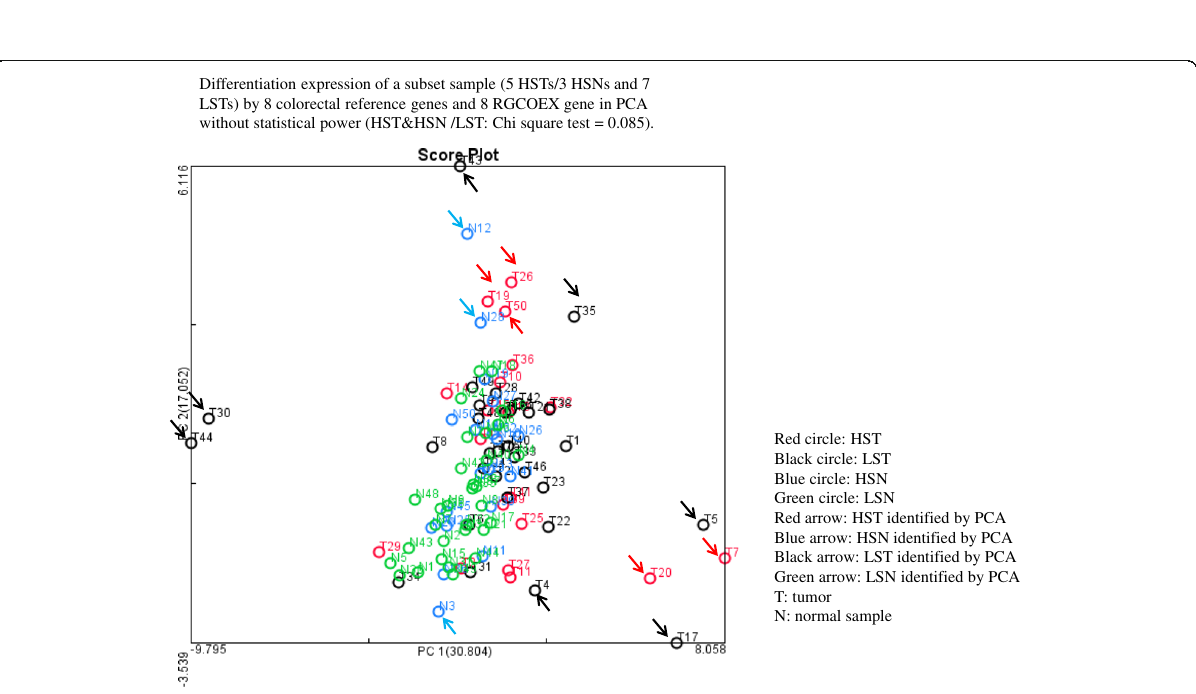
Fig. 6 PCA analysis of combination with 8 reference genes and 8 RGCOEX genes in 50 CRC pairs (TCGA). Differentiation expression of a subset sample (5 HSTs/3 HSNs and 7 LSTs) by 8 colorectal reference genes and 8 RGCOEX gene in PCA without statistical power (HST&HSN /LST: Chi square